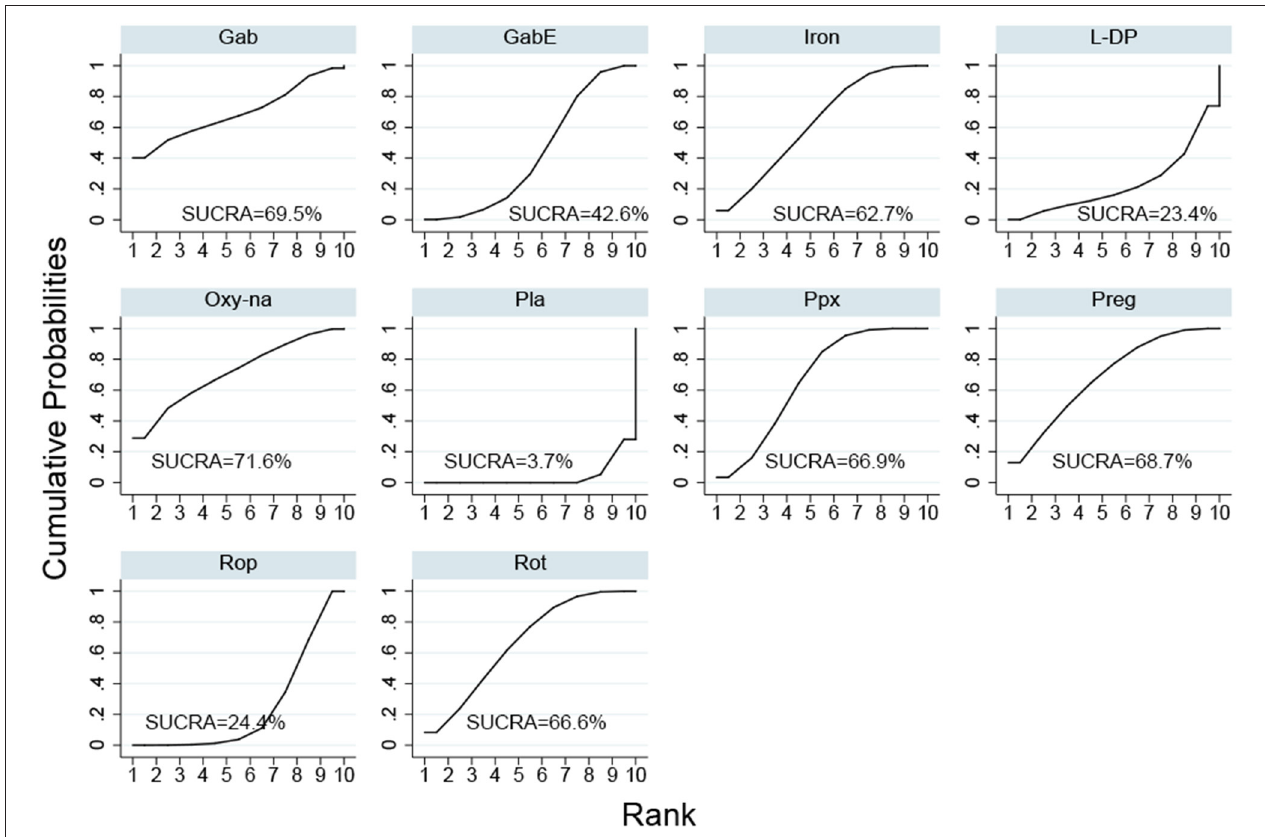
FIGURE 5 | Surface under the cumulative ranking curve (SUCRA) of the rest of drugs after excluding cabergoline. (Gab, Gabapentin; GabE, Gabapentin enacarbil; L-DP, Levodopa; Rot, Rotigotine; Ppx, Pramipexole; Cab, Cabergoline; Rop, Ropinirole; Preg, Pregabalin; Oxy-Na, Oxycodone-naloxone; Pla,